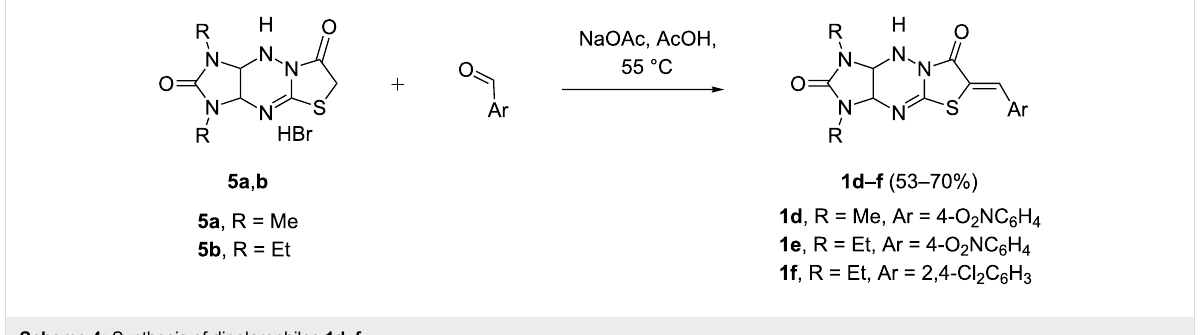
Scheme 4: Synthesis of dipolarophiles 1d–f .